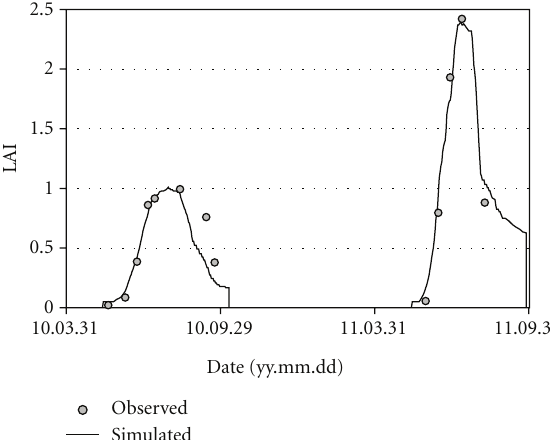
Figure 1: Observed and simulated leaf area index (LAI) values for the 1st parcel (fertilized, nonirrigated) of the experiment.